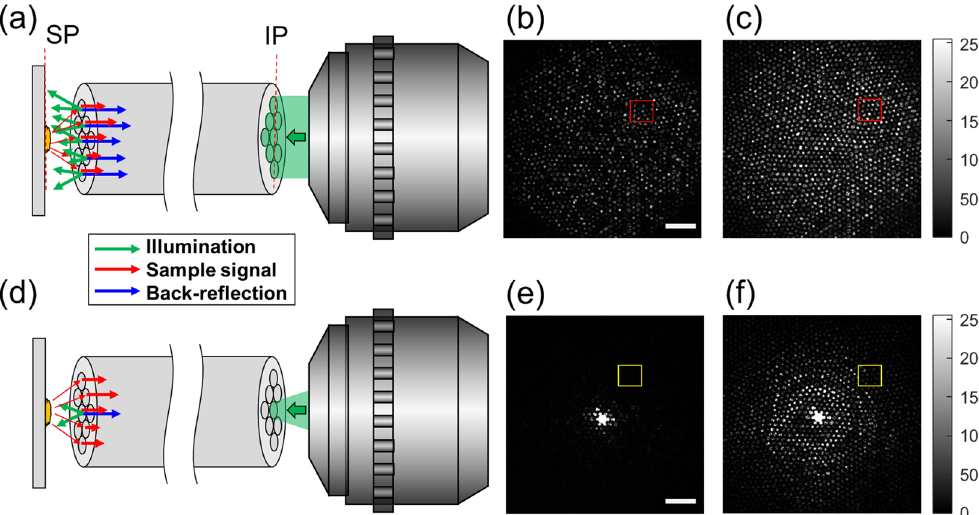
Figure 1. Schematic layouts of the WIWD and SIWD detection. ( a ) The conventional wide-field illumination and wide-field detection (WIWD) method. Green shading and green arrows indicate illumination. Blue and red arrows represent back-reflection noise at the distal end of the fiber and the backscattered light from the target object, respectively. IP: illumination plane, SP: sample plane. ( b , c ) Intensity images recorded at the IP without and with a target object, respectively. Scale bar: 20 μ m. Color bar: intensity in arbitrary units. The color scales of ( b , c ) are the same. ( d ) The single-core illumination and wide-field detection (SIWD) method. ( e , f ) Same as ( b ) and ( c ), respectively, but for the SIWD method. Scale bar: 20 μ m. Color bar: intensity in arbitrary units. Color scales of ( e ) and ( f ) are the